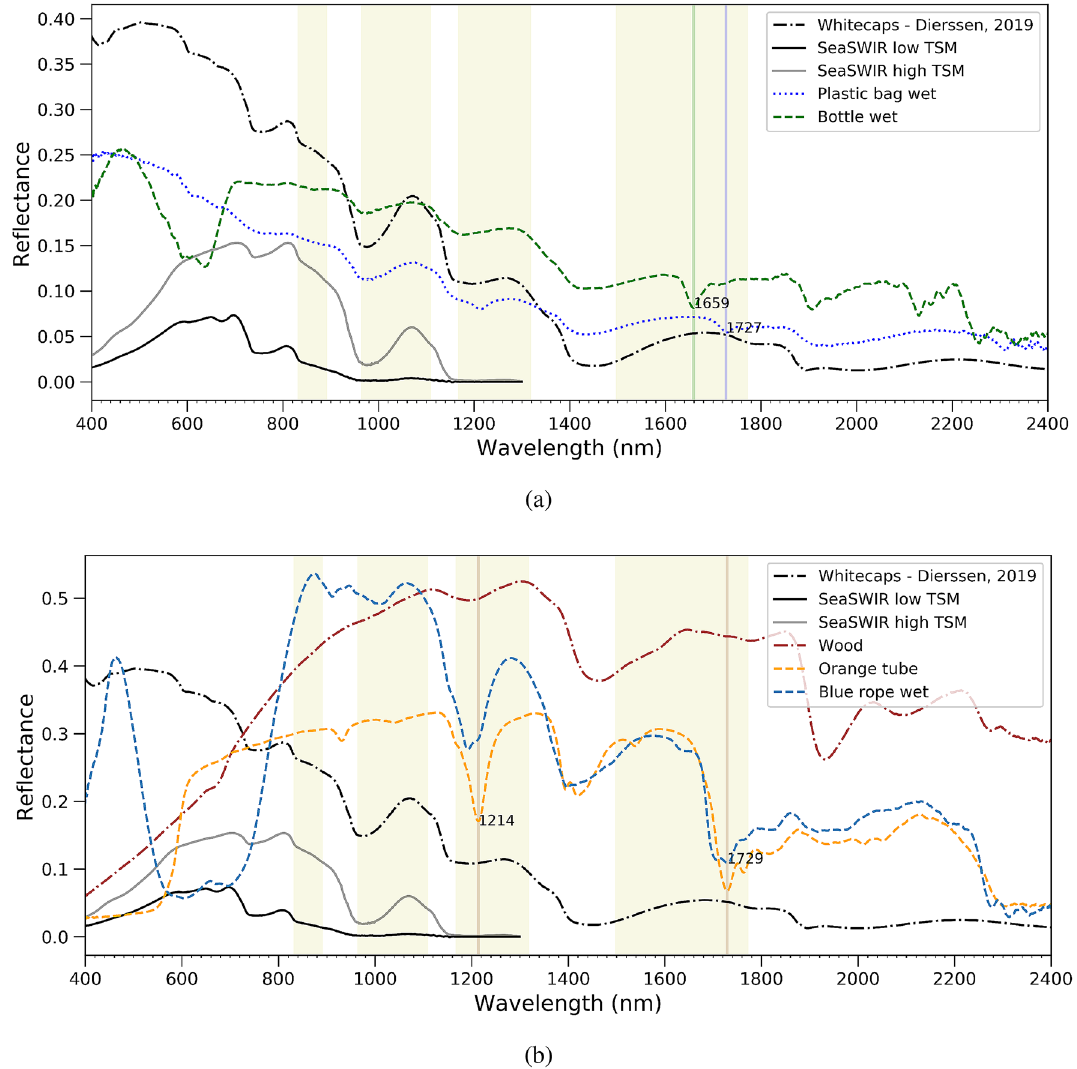
Figure 4. Spectral reflectance of natural and anthropogenic materials ( a ) whitecaps modelled after 27 , SeaSWIR measurements of Total Suspended Matter 35 , wet plastic bag and water bottle ( b ) wood, orange tube and wet blue rope. The vertical line indicate major absorption